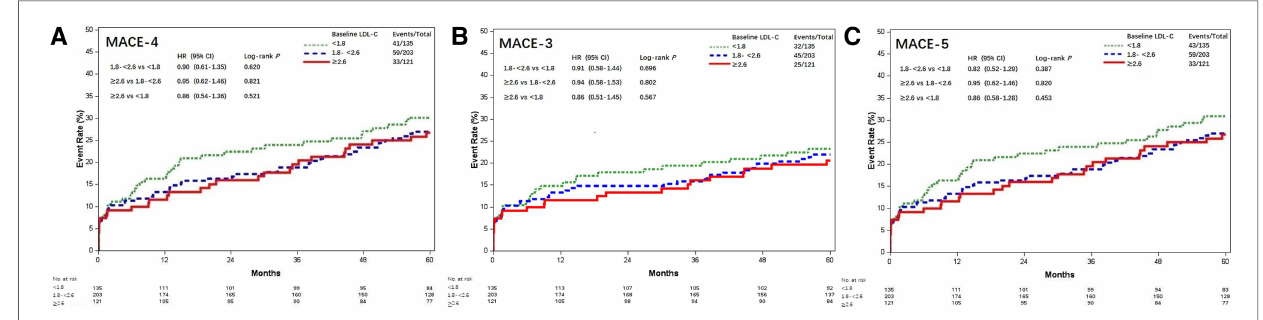
FIGURE 1 Kaplan – Meier curves of MACE among different baseline LDL-C levels (mmol/L). Kaplan – Meier estimates for freedom from ( A ) MACE-4, ( B ) MACE-3, and ( C ) MACE-5. MACE, major adverse cardiovascular events; LDL-C, low-density lipoprotein cholesterol; MACE-4, 4-point MACE; MACE-3, 3-point MACE; MACE-5, 5-point